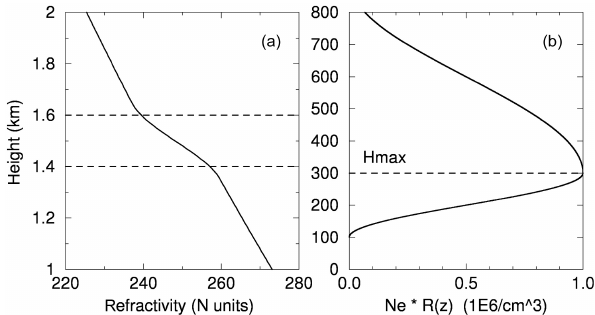
Figure A2. Atmospheric refractivity (a) and ionospheric electron density (b) used in the